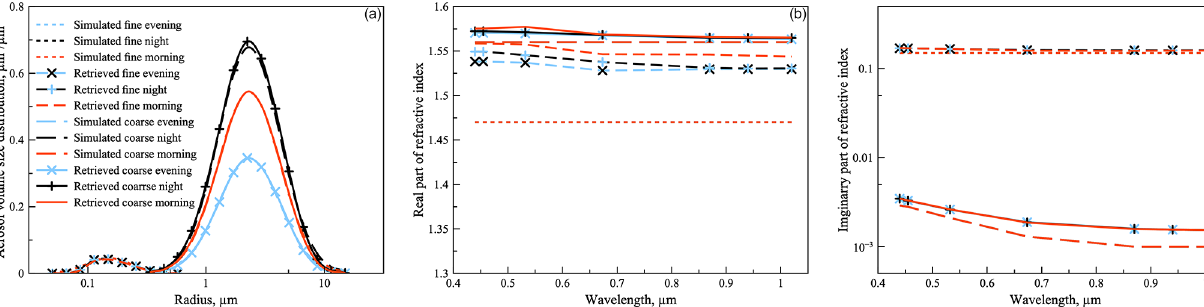
Figure 3. Aerosol volume size distributions (a) , real (b) and imaginary parts (c) retrieved from simulated data depicting non-monotonic change in aerosol coarse-mode